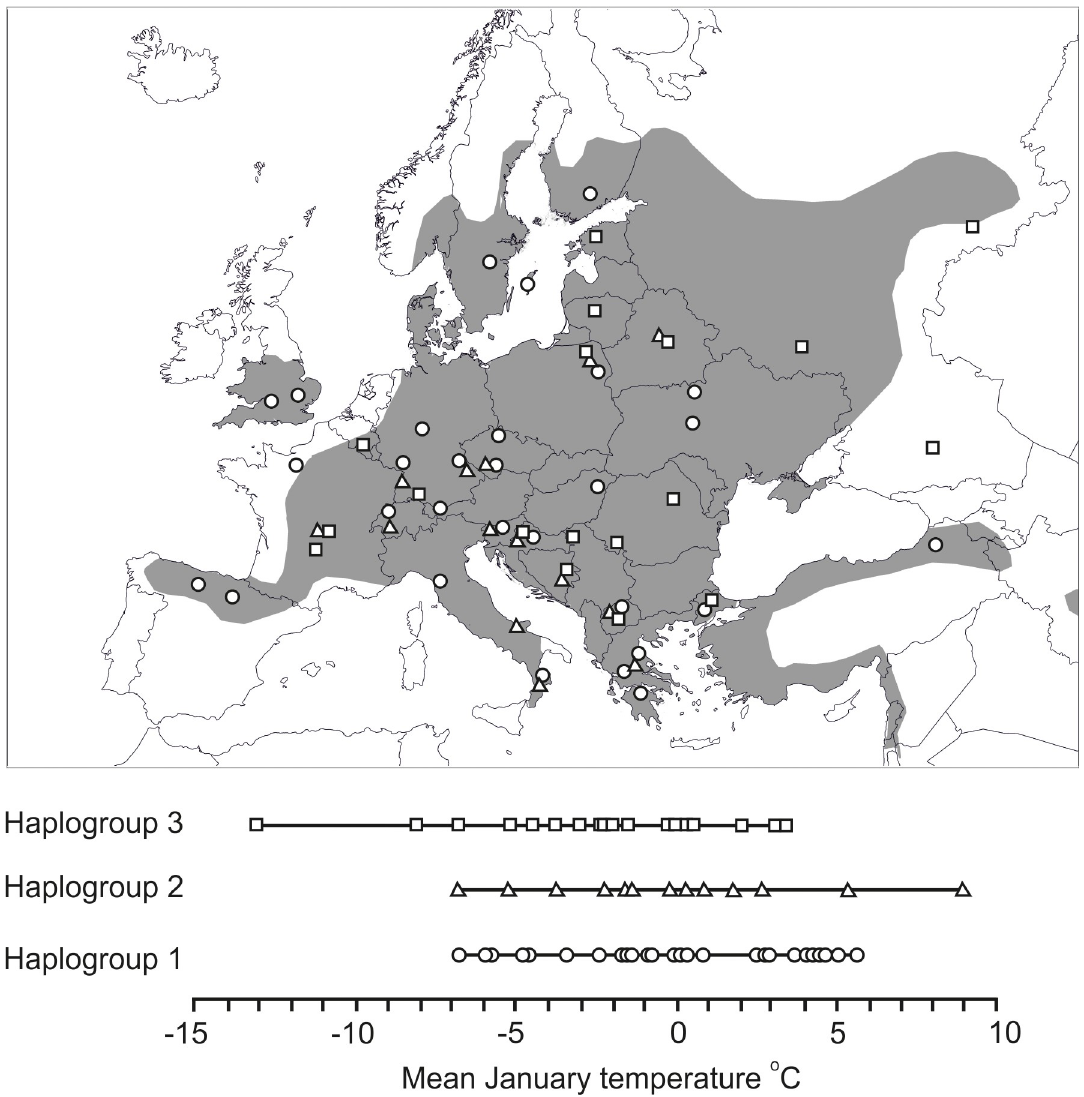
Fig 4. Geographic distribution of cyt b haplotypes of yellow-necked mice based on sequences derived from this study and the analoque cyt b fragment from the published data (sources in S2 Table). Lower panel: Mean January temperature (˚C) in each of the sampling points, where the individuals belonging to haplogroups 1–3 were found. Shapes of symbols indicate assignment to haplogroups based on Maximum Likelihood phylogenetic tree: circles–Haplogroup 1, triangles–Haplogroup 2, squares Haplogroup 3. In dark grey: the range of the yellownecked mouse in Europe (from: